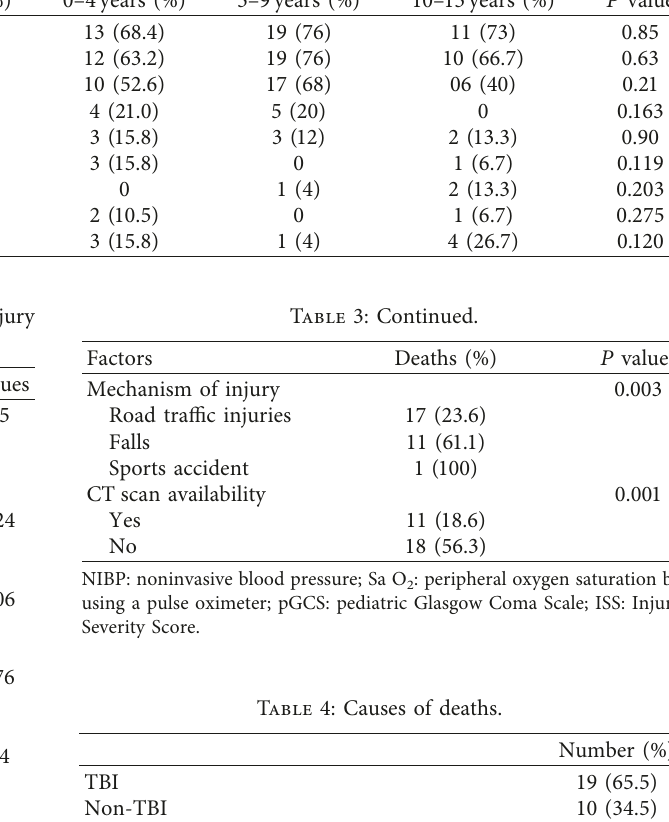
TBI: traumatic brain